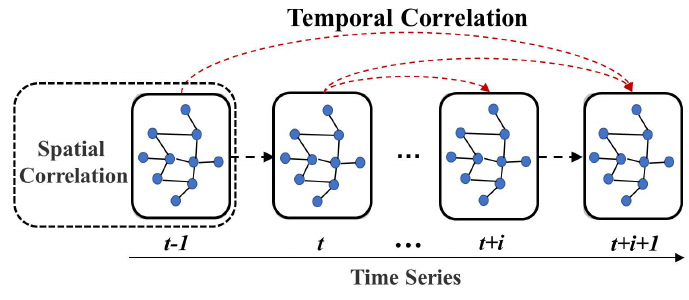
Figure 1. Spatial-temporal correlation of traffic